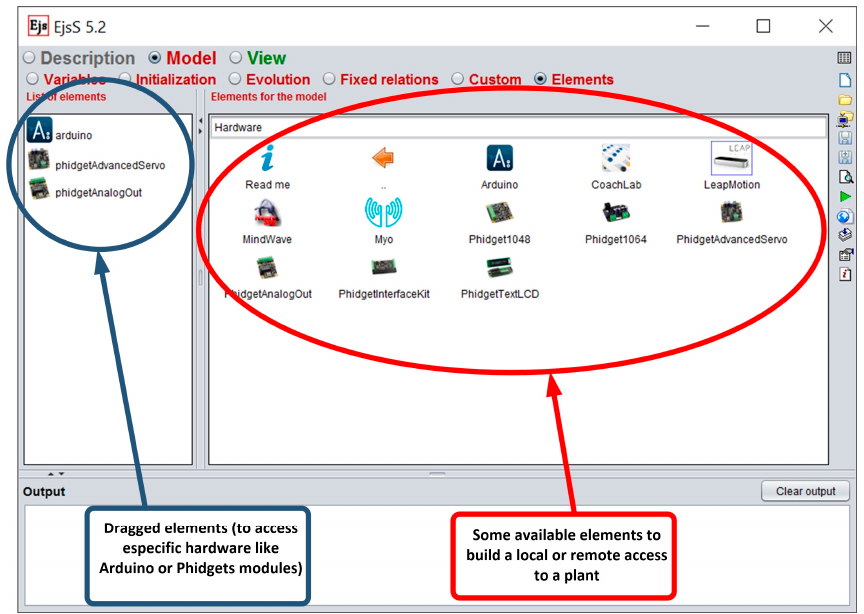
Figure 2. Some elements developed for EJS to access hardware platforms.